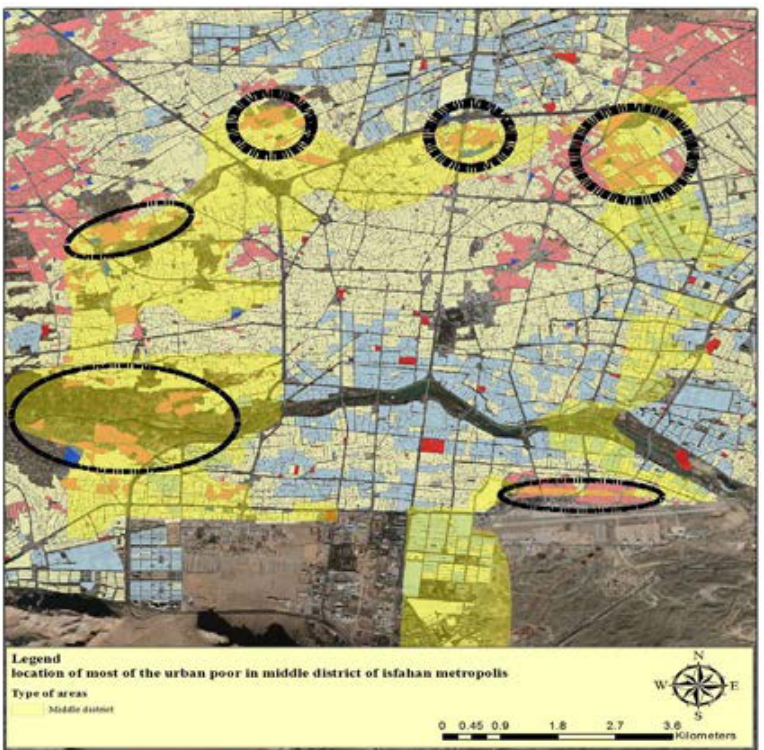
Fig. 11: The spatial concentrations of urban poor (UPRDS) in the middle district